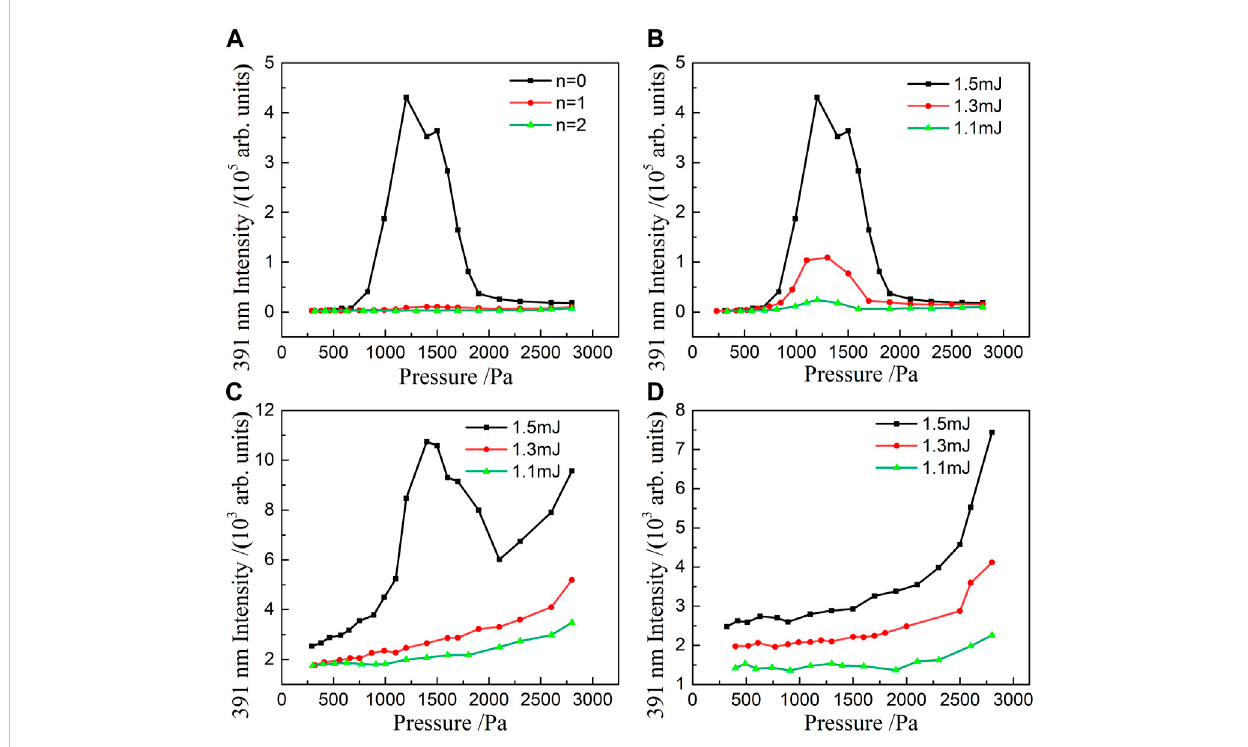
FIGURE 5 (A) Evolution of the emission at 391 nm with nitrogen gas pressure for different TCs when the pulse energy is 1.5 mJ. (B – D) 391-nm emission intensity versus the gas pressure for different pulse energies with the TC of 0,1 and 2,